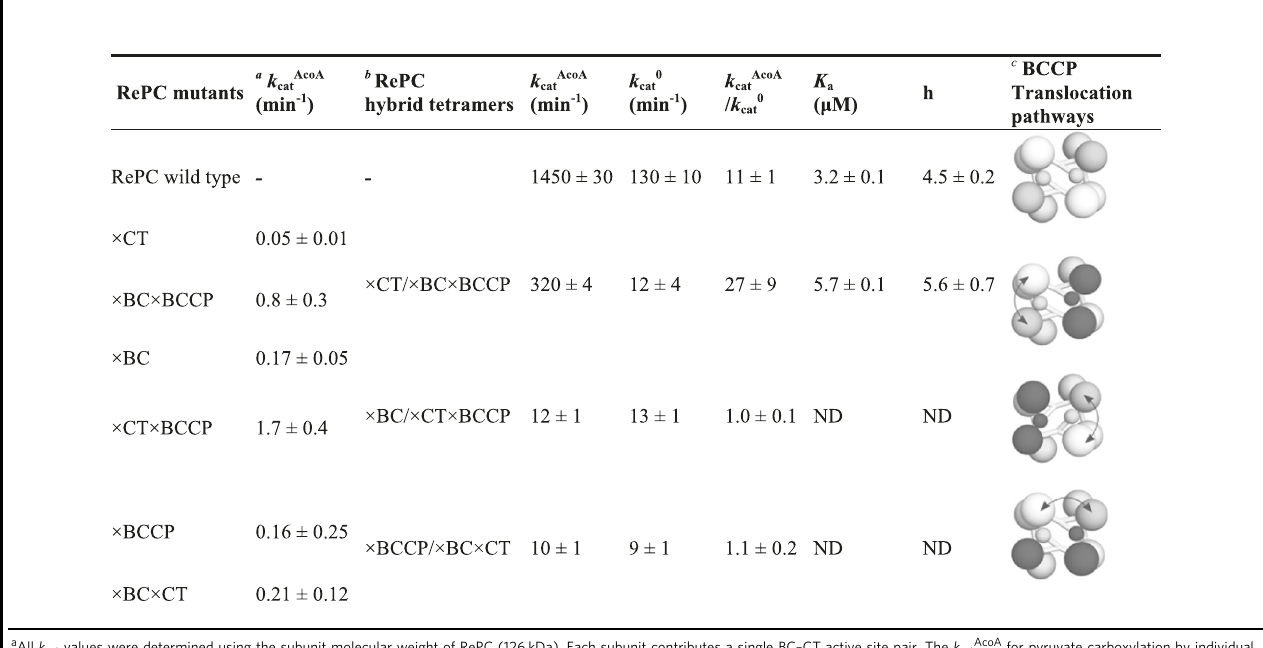
Table 2 Activation by acetyl coenzyme A of wild type and mutated RePC and hybrid